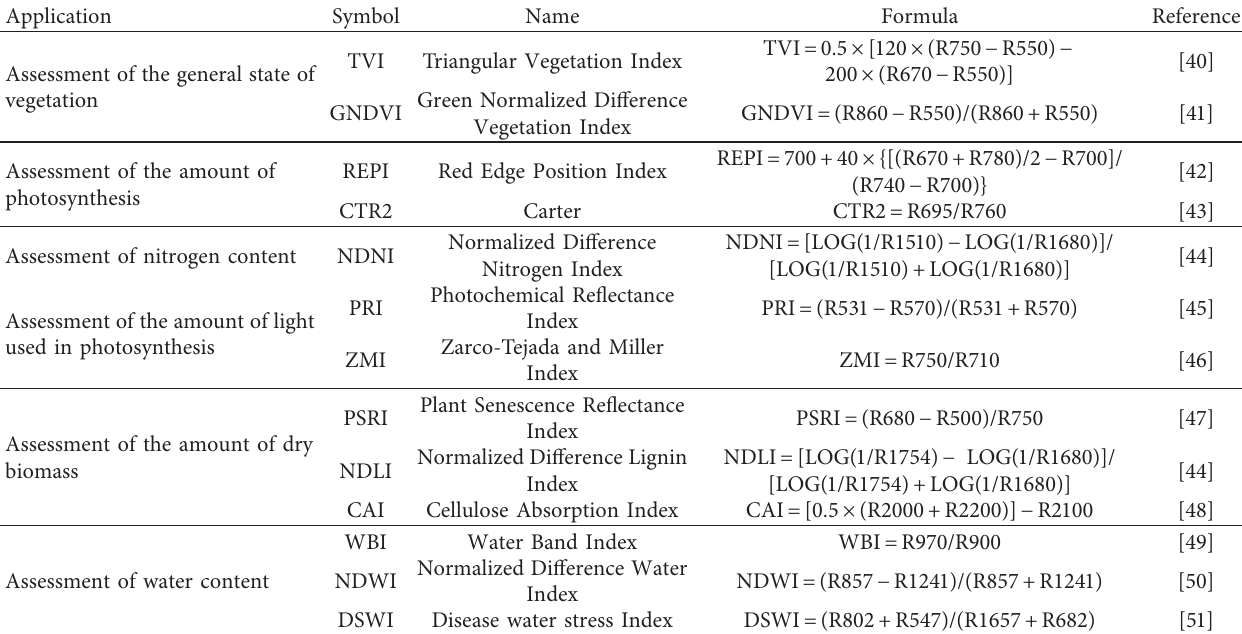
Table 1: Remote estimation of crop fractional vegetation covers: the main remote sensing vegetation